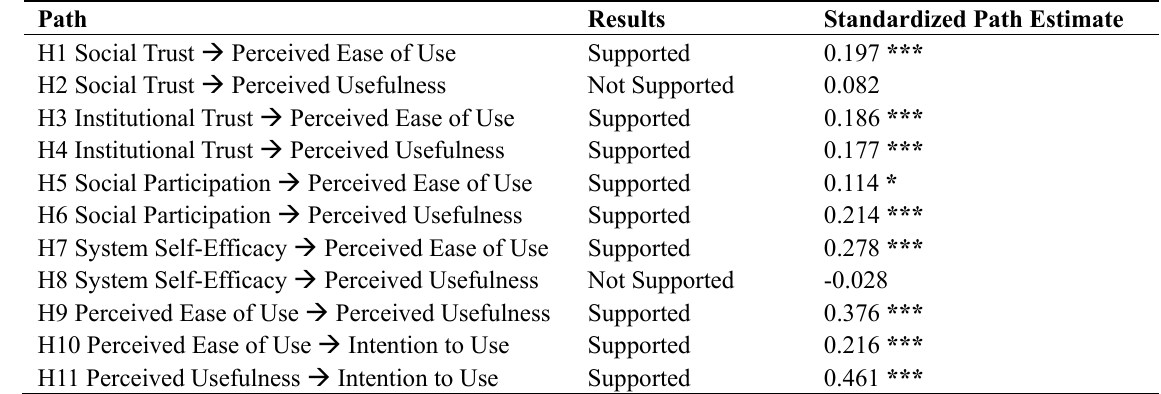
Table 5. Hypotheses Validated Results.